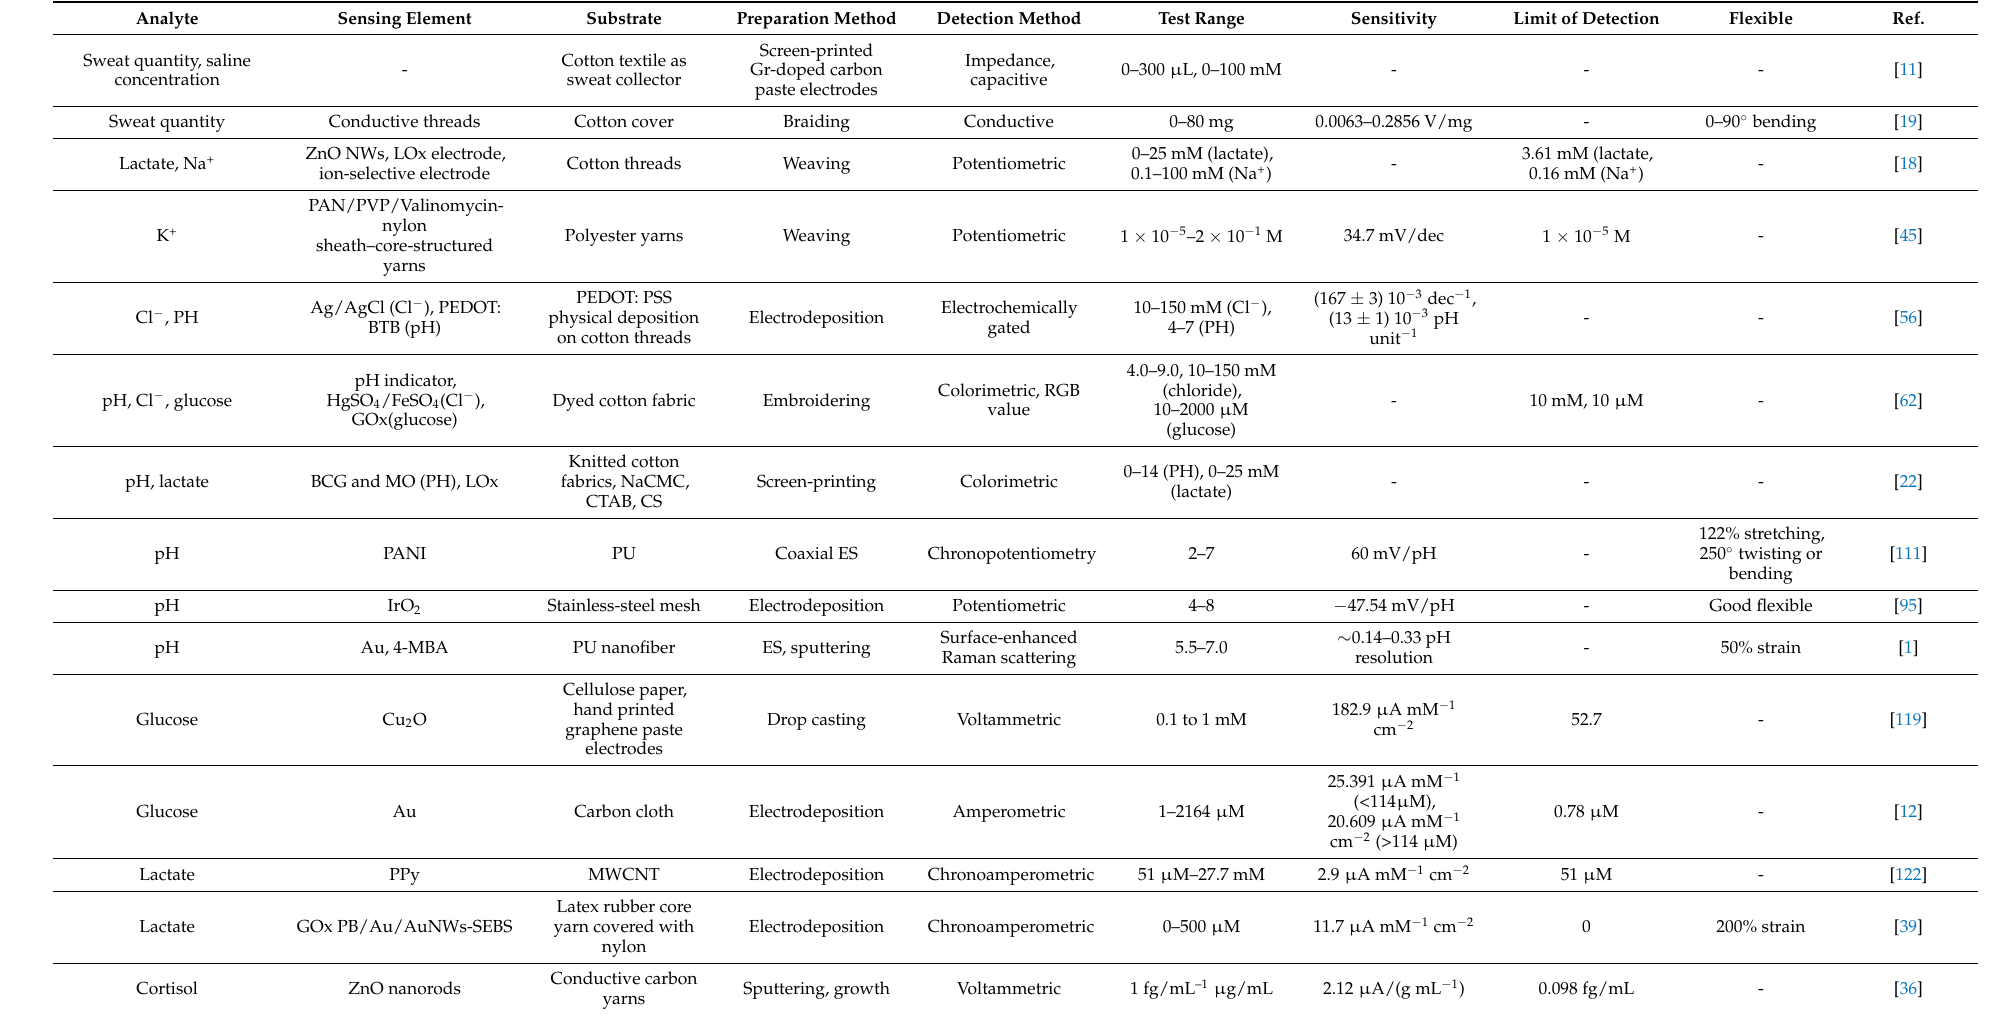
Table 3. Classification of sweat sensing